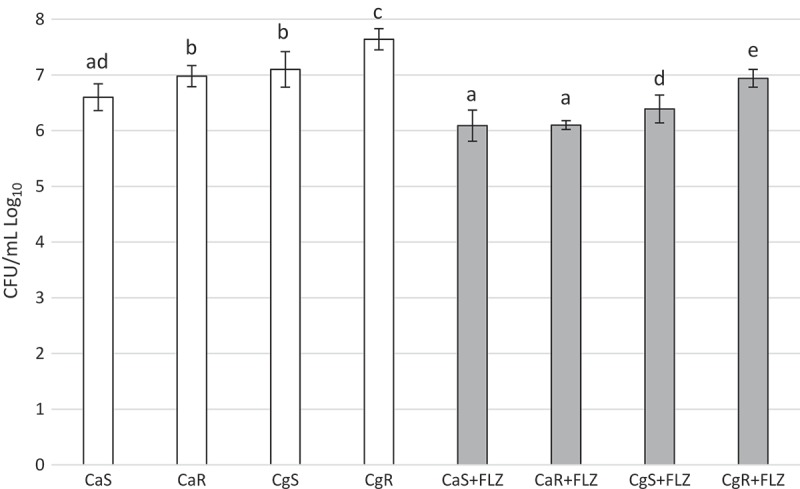
Mean values and standard deviations of Log10 (CFU/mL) of CaS, CaR, CgS, and CgR in the absence (white bars) or in the presence (gray bars) of fluconazole (FLZ). Bar charts were applied for normal data submitted to parametric analysis (ANOVA). Equal letters designate statistical correspondence (p < 0.05).